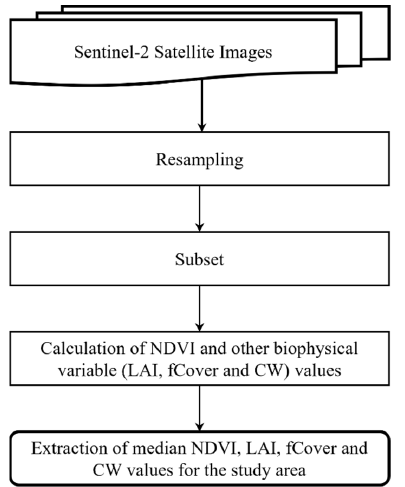
Figure 7. Flowchart for processing Sentinel-2 satellite images.